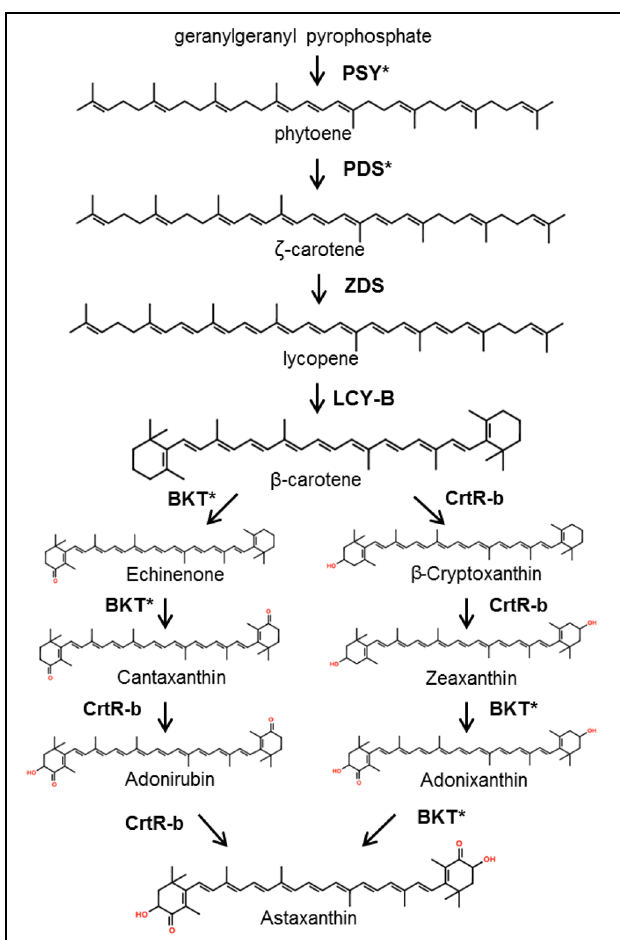
FIGURE 3 | Proposed pathway for astaxanthin synthesis in green microalgae. Asterisks denote enzymes which have been targeted for metabolic engineering, as shown in Table 2 . PSY, phytoene synthase; PDS, phytoene desaturase; ZDS, ζ -carotene desaturase; LYC-B, lycopene β -cyclase; BKT, β -carotene ketolase; CrtR-b, β -carotene hydroxylase. Modified from (Grünewald et al., 2001; Ye et al., 2008). Synthesis of β -carotene occurs in the chloroplast, while there is evidence that the subsequent steps could also take place in the cytoplasm (Grünewald et al., 2001; Guedes et al.,